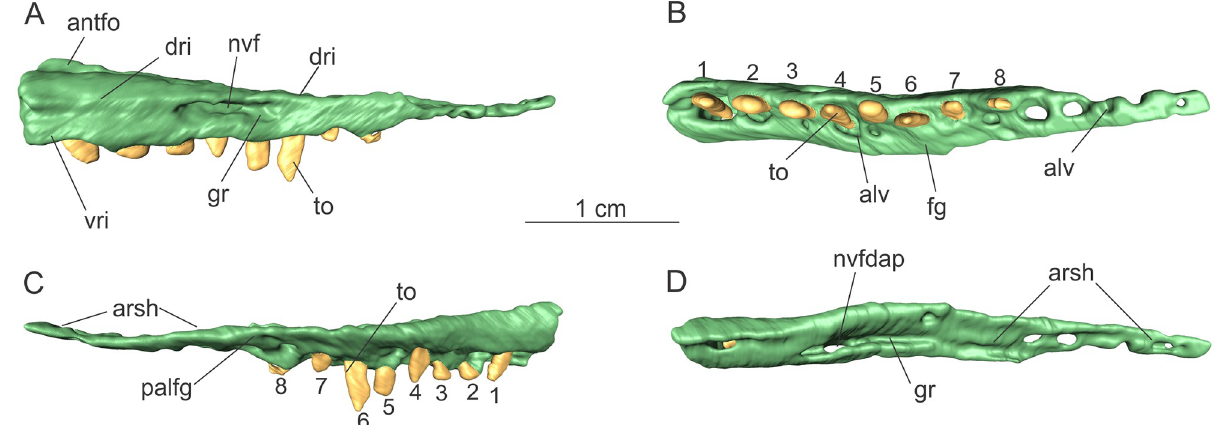
Fig 1. Posterior ramus of the right maxilla of the specimen MCP-3845-PV of Saturnalia tupiniquim in lateral (A), ventral (B), medial (C), and dorsal (D) views. Abbreviations: alv— alveolous; antfo— antorbital fossa; arsh— articulation shelf; dri— dorsal ridge on the lateral surface; fg— flange; gr — groove; nvf— neurovascular foramina; to— tooth; nvfdap— dorsal aperture assocaied to the neurovascular foramen; palfg— palatine flange; vri— ventral ridge on the lateral surface.